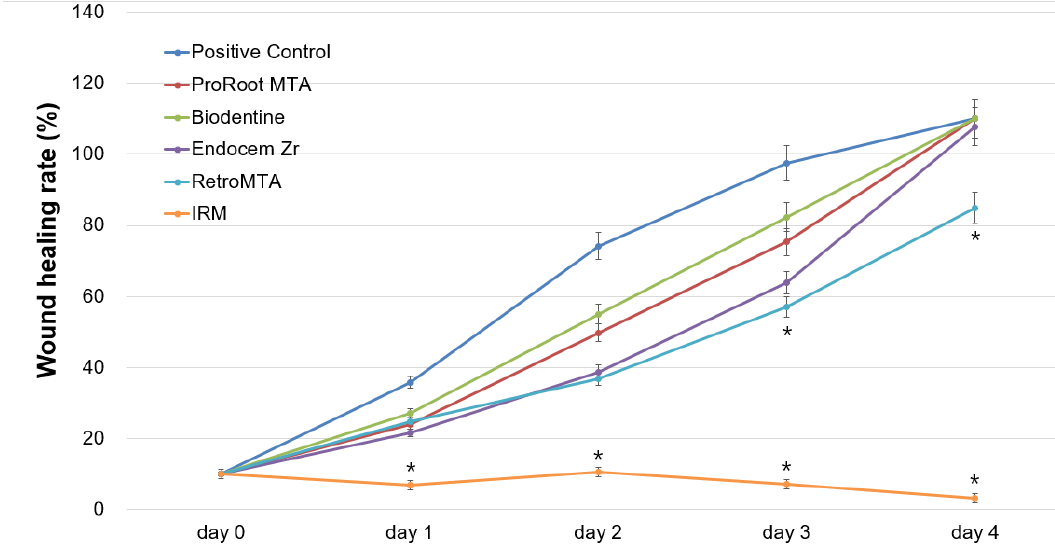
Figure 2. Wound healing rate of all tested calcium silicate-based cements. Asterisks represent statistically significant differences between the positive control and experimental groups.